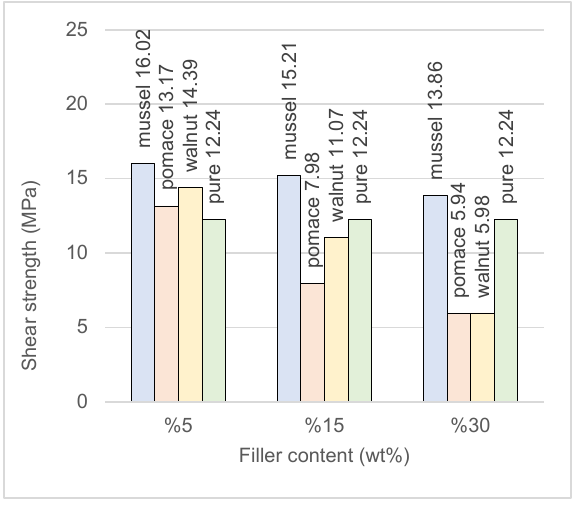
Figure 3 . Average shear strengths of the 38 µm adhesive joints .